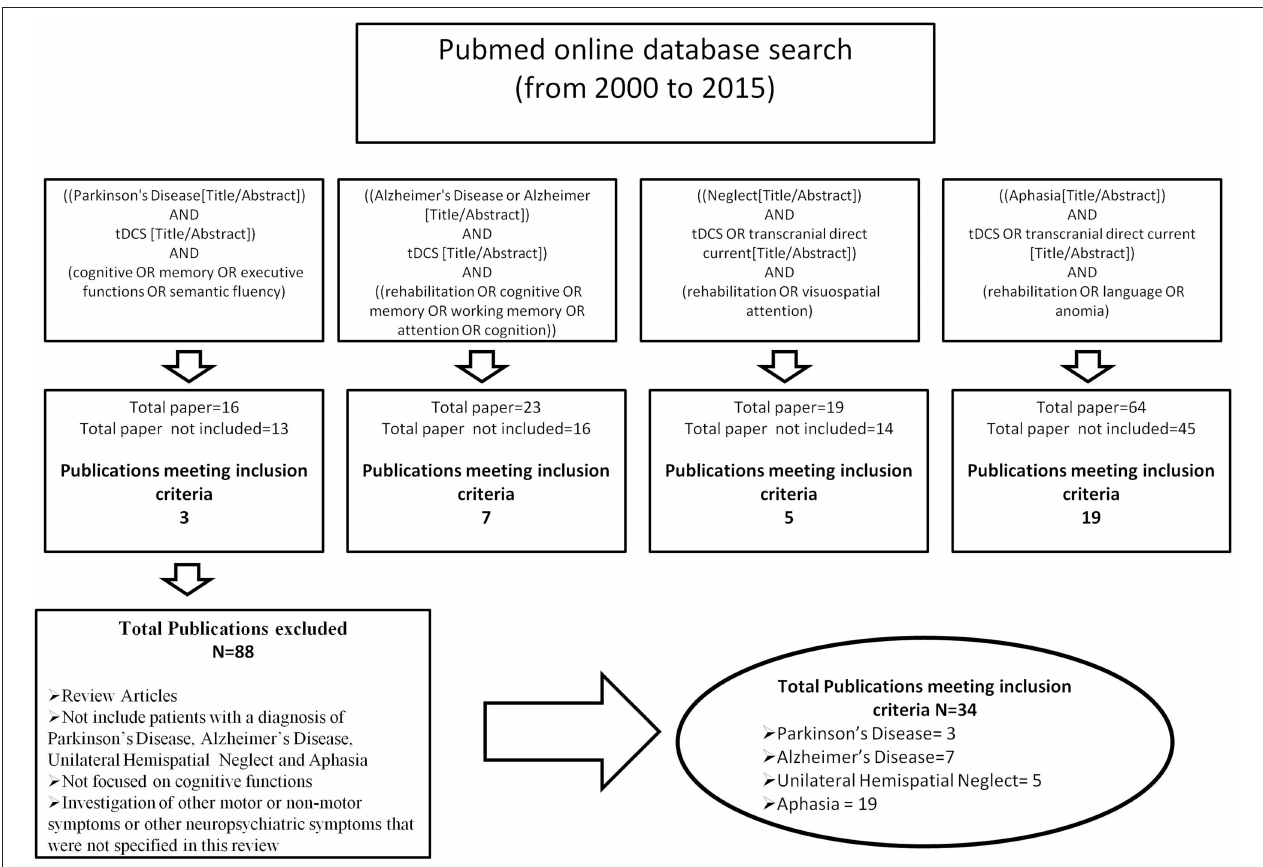
FIGURE 1 | Database key words search